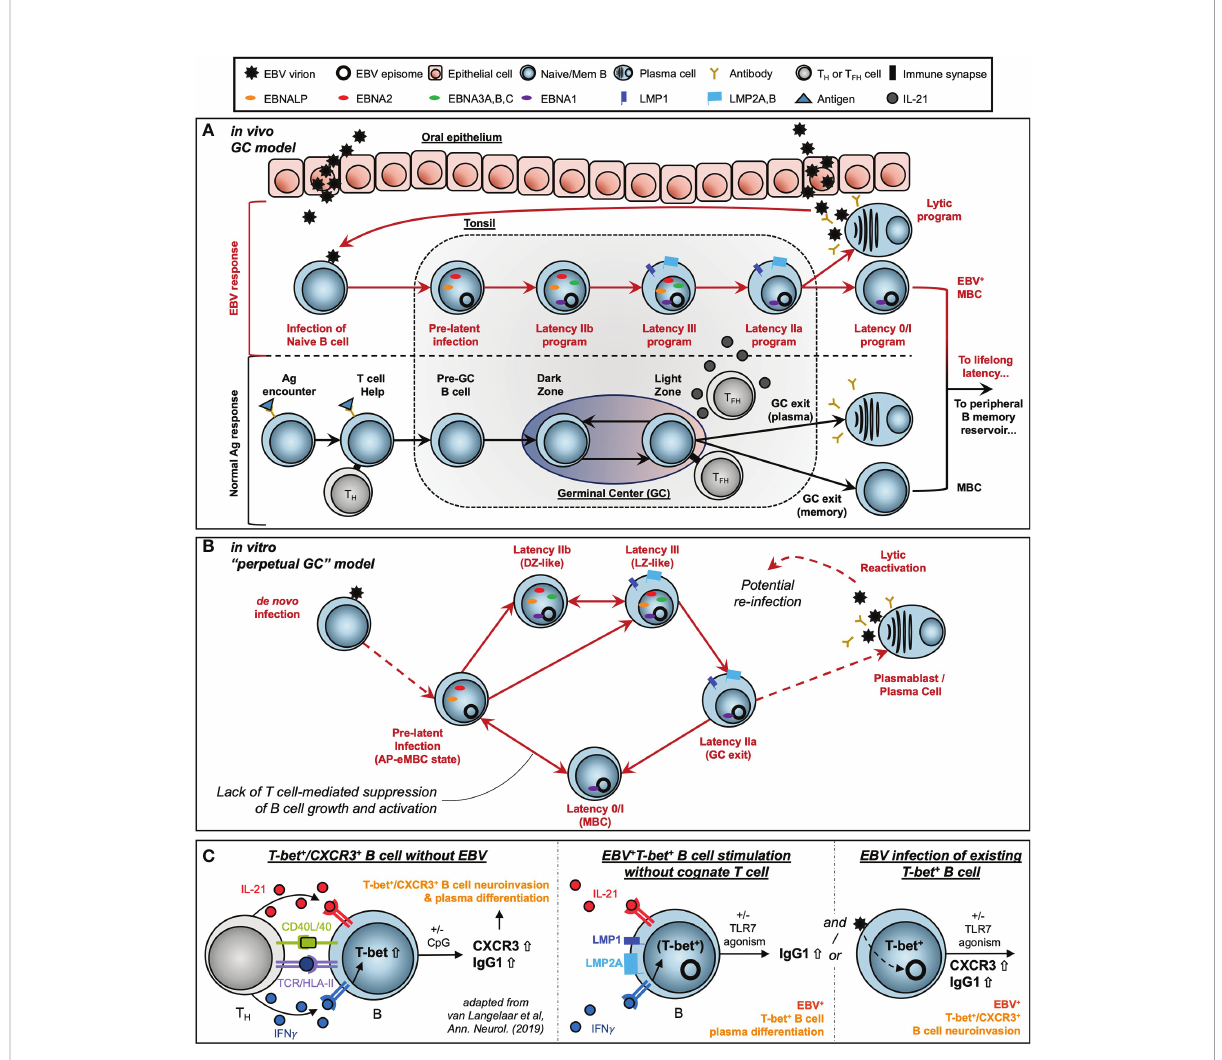
FIGURE 8 Models of EBV-driven germinal center dynamics and possible roles in priming of T-bet + atypical MBC pathogenesis. (A) The Germinal Center (GC) model of EBV infection in vivo . (B) A model of perpetual GC dynamics within EBV-immortalized B cells in vitro . (C) Models of atMBC behaviors associated with pathogenic autoimmunity and potential EBV-induced priming of these